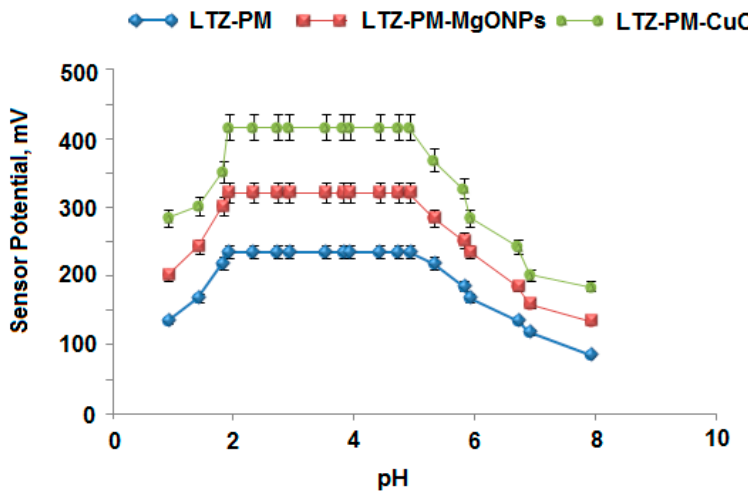
Figure 8. Effect of pH on the fabricated conventional LTZ-PM and modified metal oxide LTZ-PM-MgONPs and LTZ-PM-CuONPs coated wire sensors using 1.0 × 10 − 4 mol L − 1 of LTZ solu- tion.